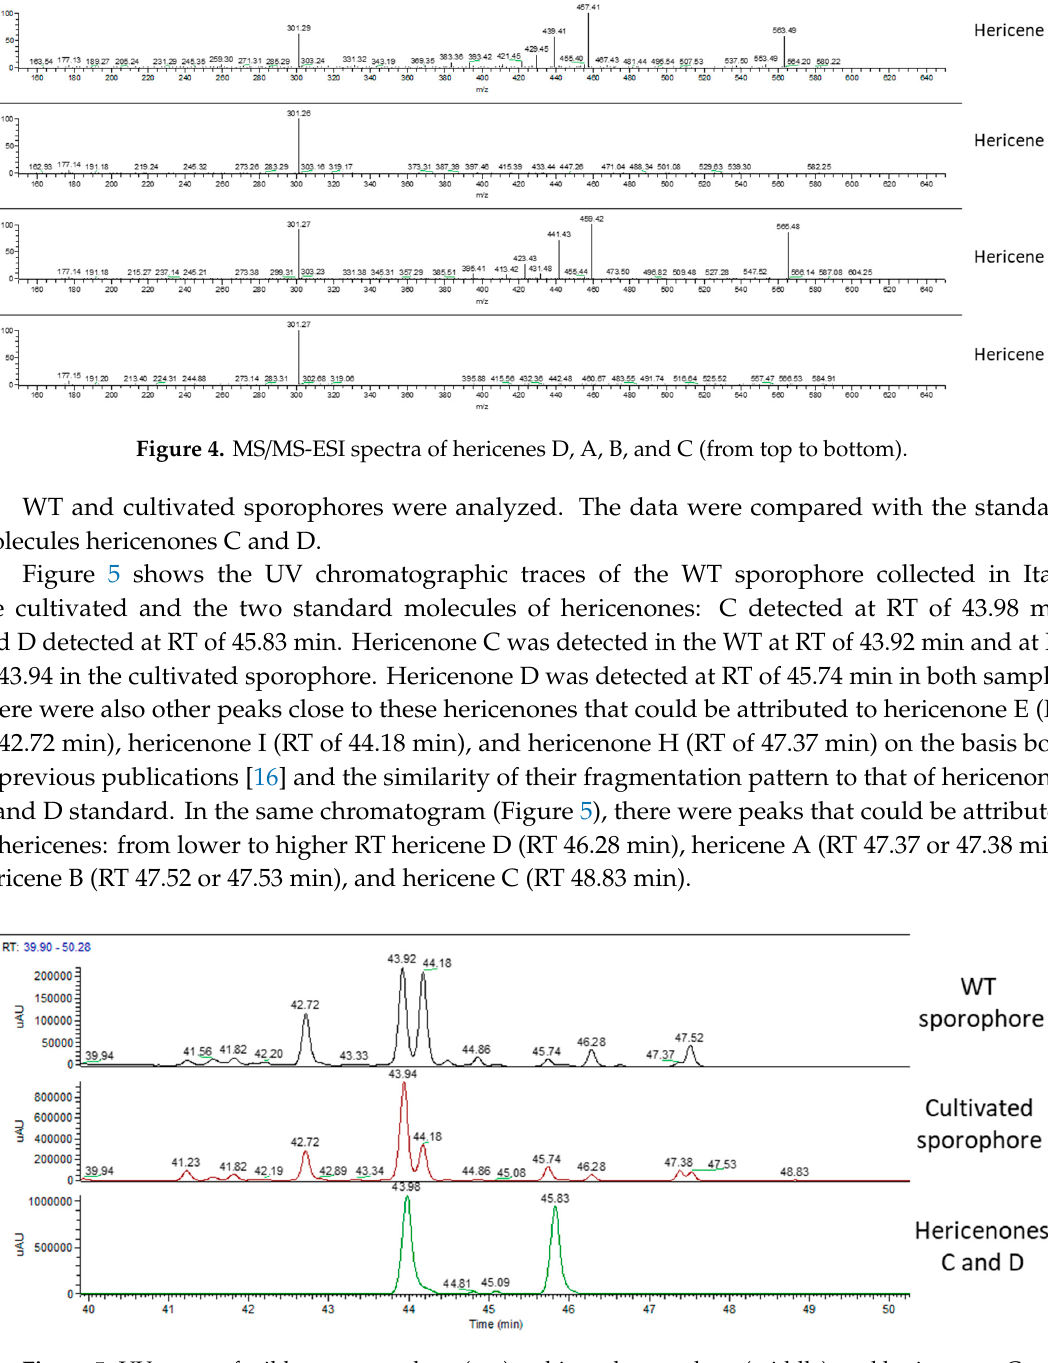
Figure 5. UV traces of wild type sporophore (top), cultivated sporophore (middle), and hericenones C (RT 43.98 min) and D (RT 45.83 min) standards (bottom).